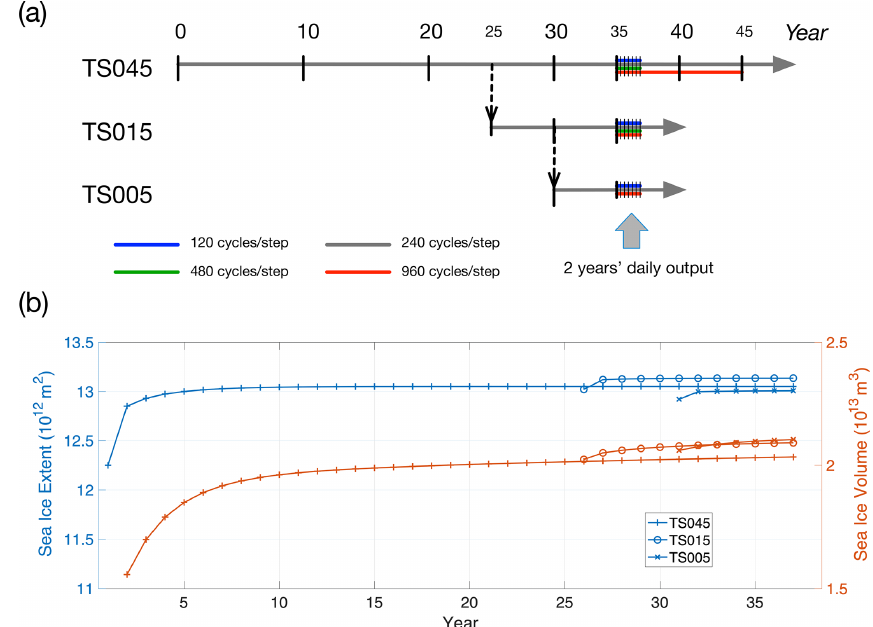
Figure 4. Spin-up experiments of sea ice simulations with TS grids (a) and spin-up of Arctic sea ice extent and volume (SIE and SIV, in panel b ) up to year 37. These experiments are based on D cases in CESM: the sea ice component CICE is forced with normal-year forcing of CORE and coupled to the slab ocean model. For TS045, the model is initialized with an ice-free condition, and the numerical integration is carried out until equilibrium. For TS015, a snapshot of the spun-up conditions of TS045 at the end of year 25 is used to initialize the integration, and the experiment is carried out for 12 years up to year 37. For TS005, a snapshot of the spun-up status of TS015 at the end of year 30 is used for model initialization, and the experiment is carried out for 7 years up to year